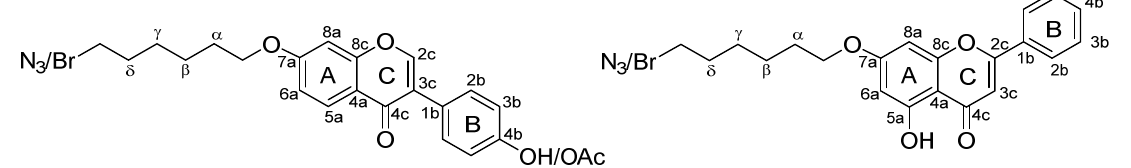
Figure 9. Numbering of the flavonoid derivatives.